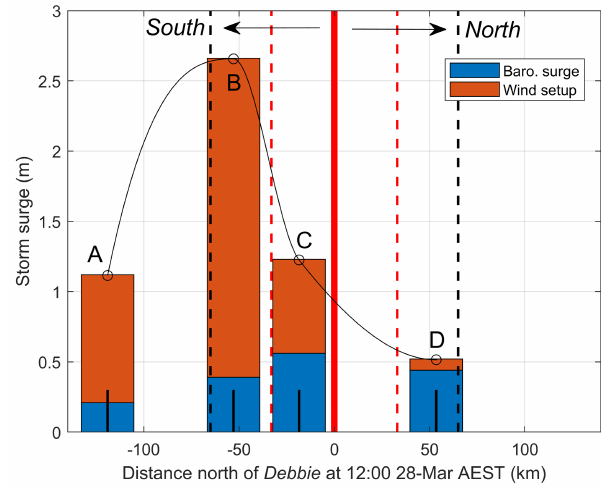
Figure 4. Maximum storm surge and components (barometric surge, blue, and wind setup, orange) plotted as a function of dis- tance from Debbie landfall at 12:00 on 28 March 2017 (solid red line), where A is Mackay, B is Laguna Quays, C is Shute Harbour and D is Bowen storm tide gauge station (black lines show centroids of each). Radius of maximum winds (RMW, red dotted lines) and radius of hurricane-force winds (RHFW, black dotted lines) are also shown. The maximum surge north and south of Debbie ’s eye (black curve and circles) demonstrates the asymmetry in the surge, skewed to the south of the cyclone